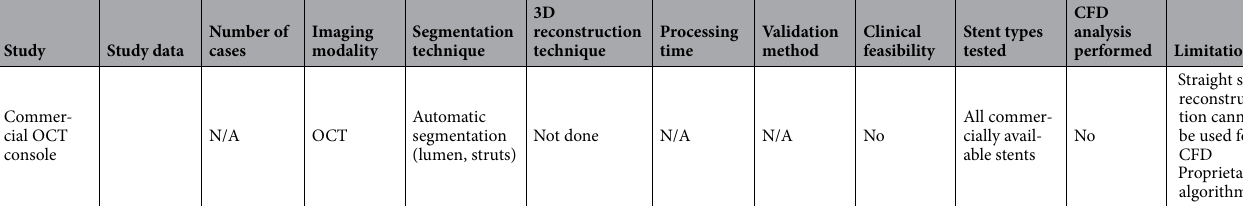
Table 5. Comparison between different stent reconstruction methods (OCT: optical coherence tomography; μCT: micro-computed tomography; MSD: mean stent diameter; CFD: computational fluid dynamics; N/A: not